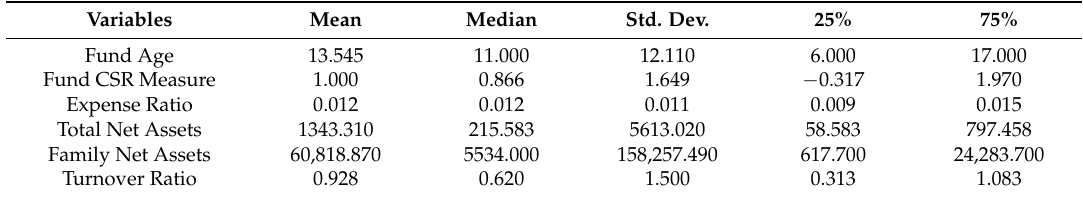
Table 1. Summary statistics